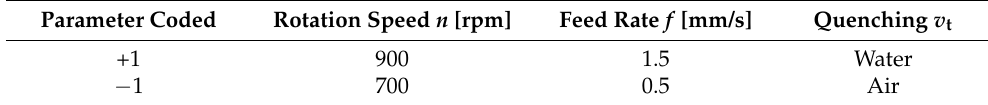
Table 2. Process parameters for the friction-spinning of steel 1.0308 tubes.